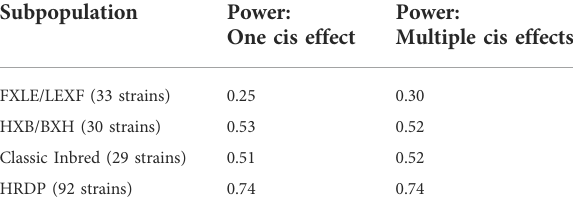
TABLE 3 Power for GEMMA LOCO applied to the two simulation settingswithciseffectsinthesubpopulationsimulations.Poweris the proportion of genes with at least one nonzero cis-SNP effect that had at least one cis-SNP with a signi fi cant association identi fi ed via GEMMA LOCO analysis of the corresponding